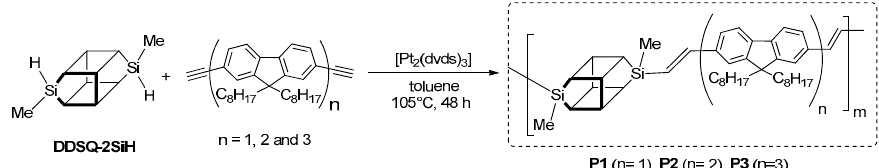
Figure 25. Synthesis of oligomers with the DDSQ unit and oligofluorenes in the main chain via hydrosilylation.